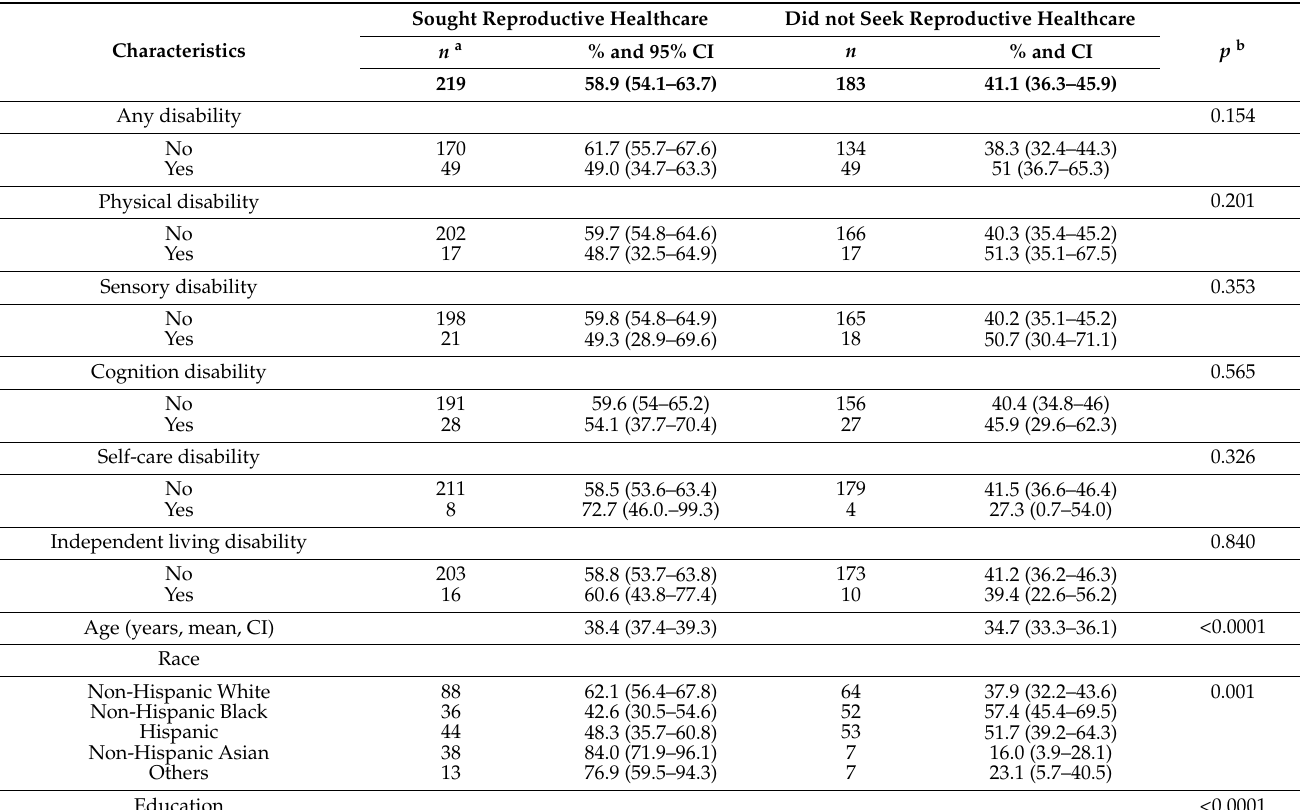
Table 2. Characteristics of affected participants who had a doctor visit for infertility ( n =